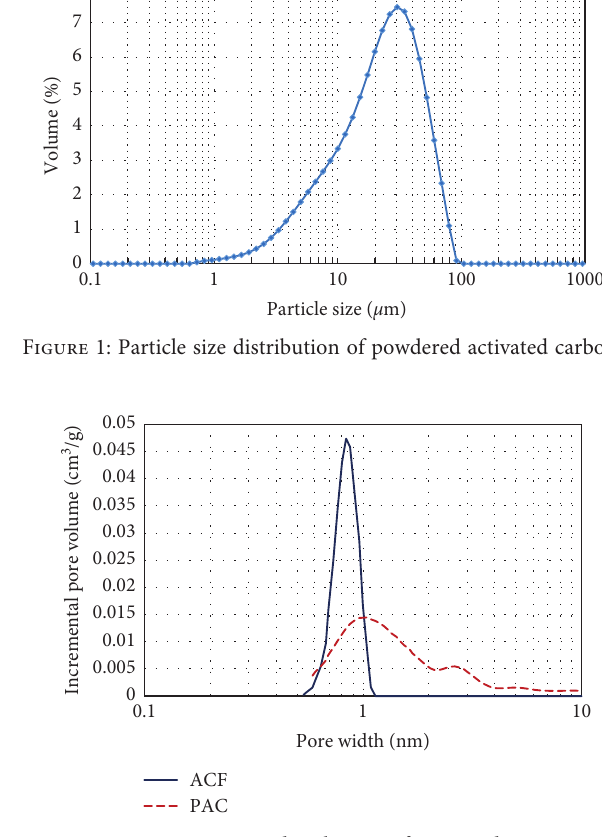
Figure 2: Pore size distribution of ACF and PAC. Table 1: Chemical oxide analysis of